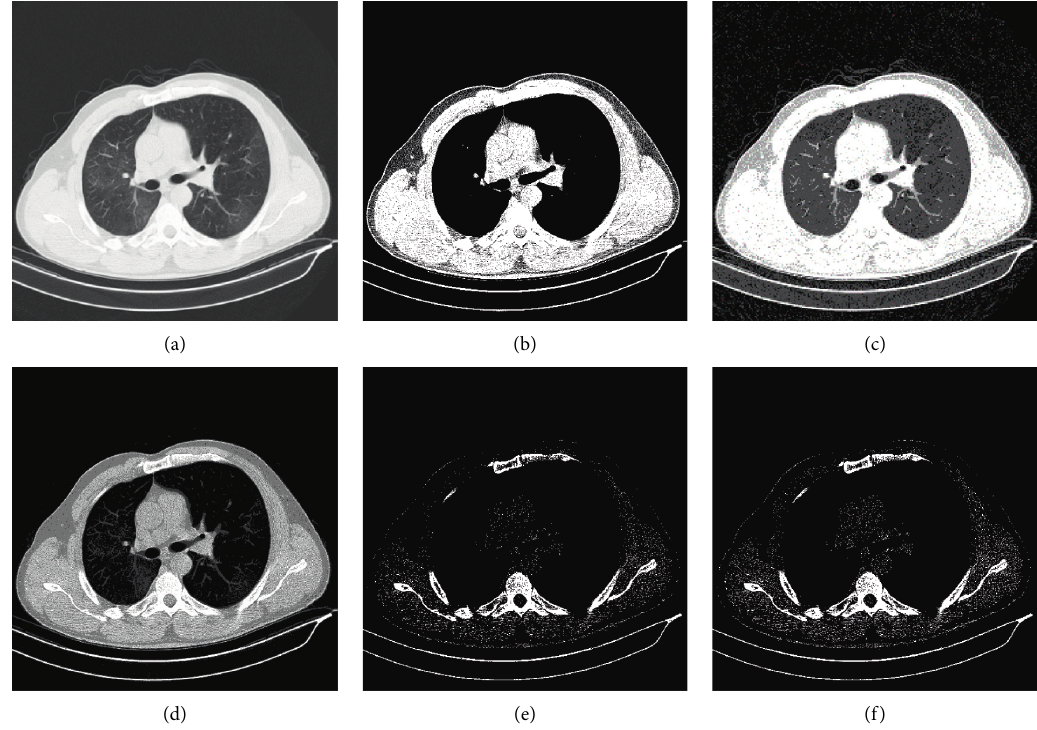
Figure 11: The comparison outcomes. (a) Original CTimage-4; (b–d) segmentation result of threshold levels 2,3, and 4, respectively, of the proposed approach; (e) segmentation results obtained by Tao [21]; (f) segmentation results obtained by Tang